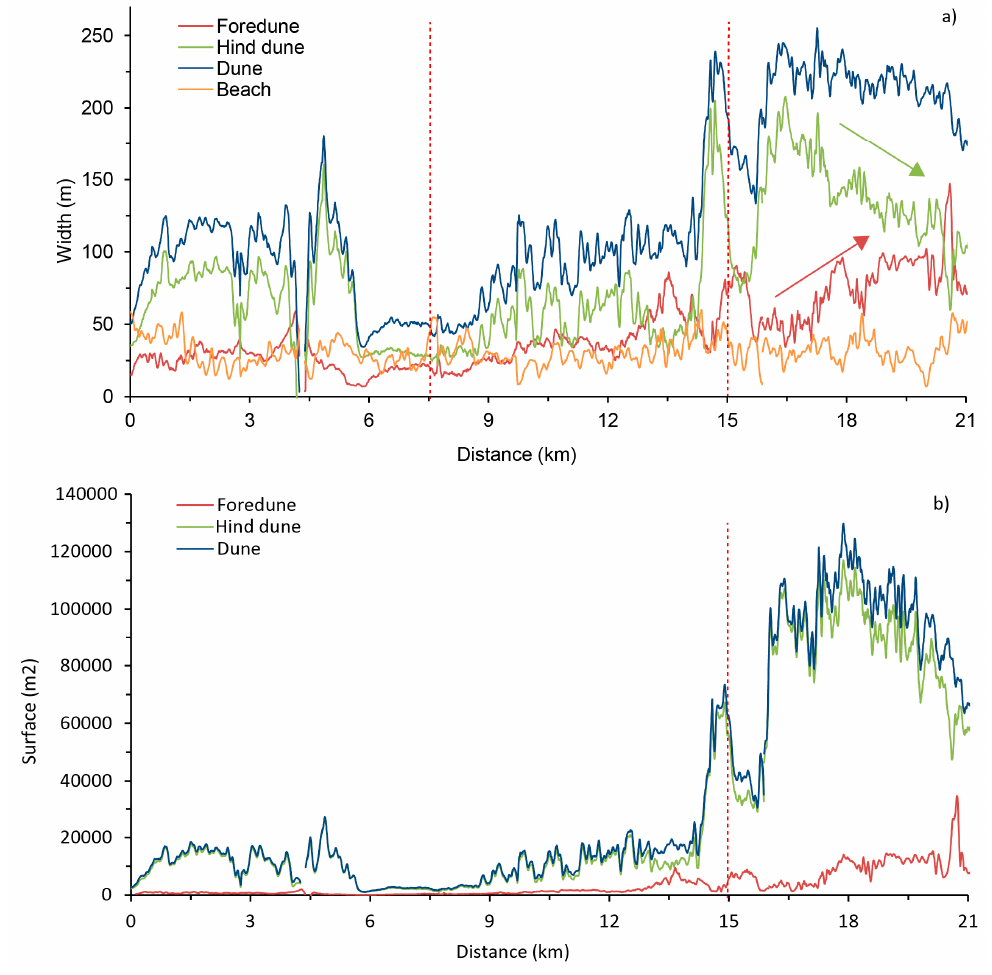
Figure 7. Description of the morphological main behavior moving from north to south: ( a ) Width vs. distance; ( b ) profile underlying the surface vs. distance. Parameters refer to the 68 m moving window.